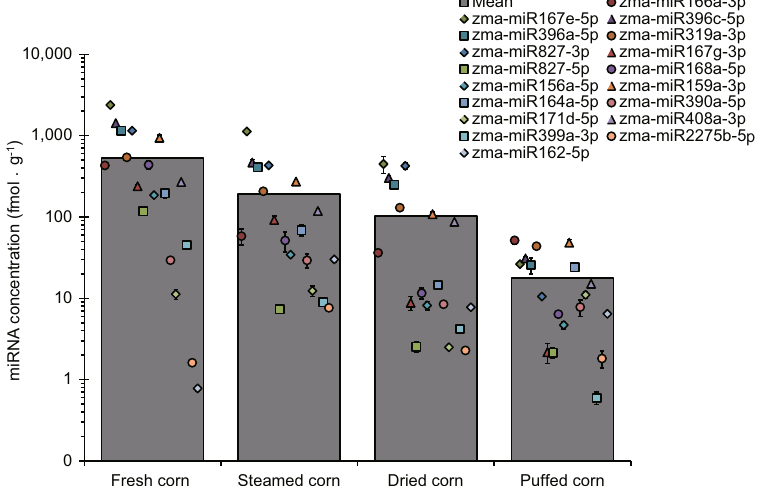
Figure 1. Identification of abundant miRNAs in fresh maize and chow diets. The average plant miRNA concentrations in cooked maize-containing chow diets, including fresh, steamed, dried and puffed maize, were evaluated by q-PCR ( n =